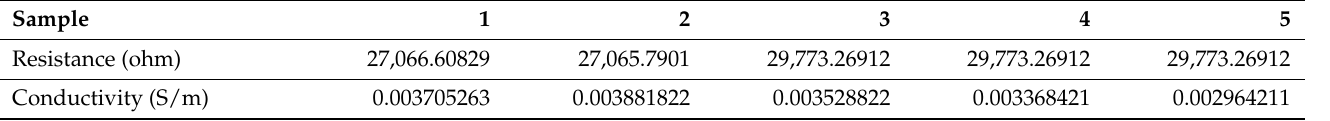
Table A16. Conductivity Data for Nylon 610 Nanocomposites with 0.5 wt% Untreated Graphite Nanosheets.